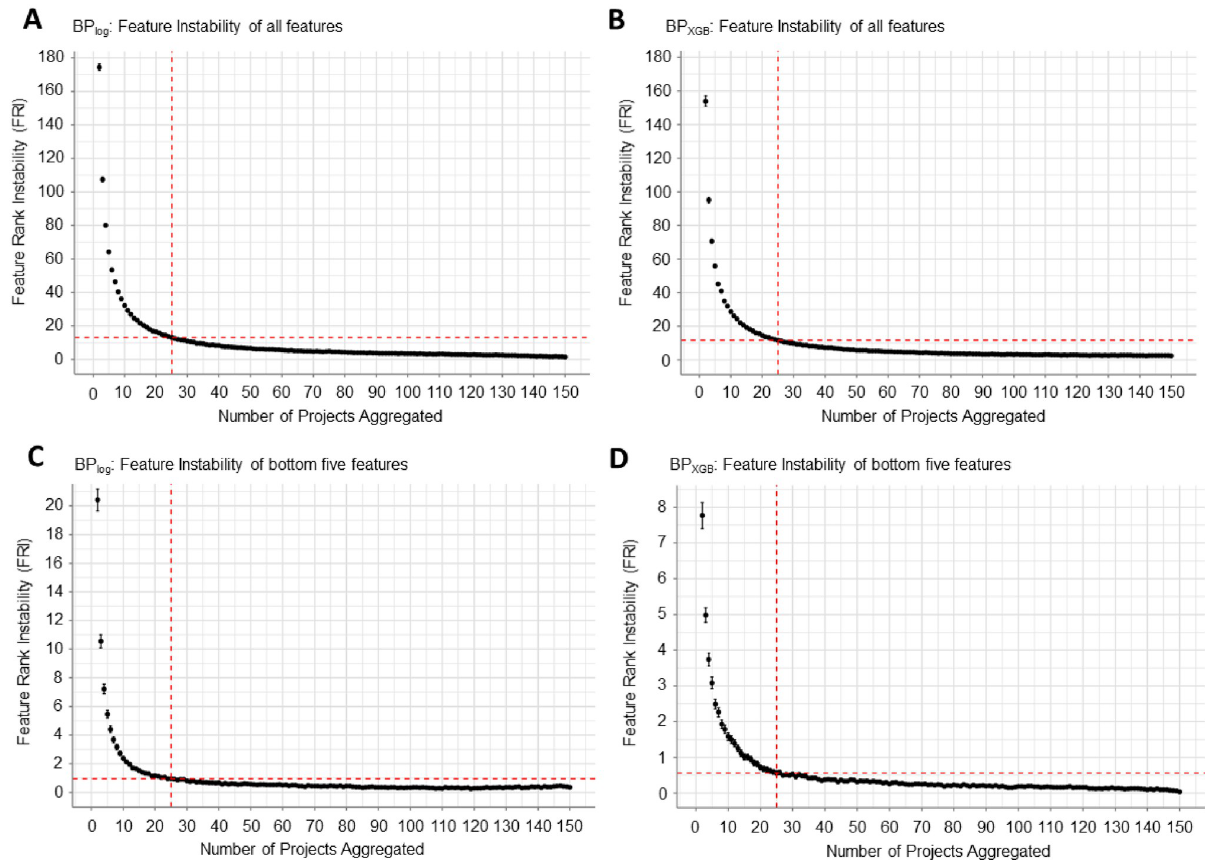
Fig 3. Feature rank instability (FRI) analysis as a function of number of projects aggregated. As the number of projects increased, FRI decreased (i.e. pFI ranking became more stable). (A, B) Expected FRI calculated for all 46 features. BP log had an average FRI of 174.40 ± 2.14 with 2-project aggregation and 13.03 ± 0.34 with 25-project aggregation (A). Similarly, BP XGB started with an average FRI of 153.83 ± 3.06 that decreased to 11.65 ± 0.33 at 25 projects (B). (C, D) Focusing only on the bottom five features by pFI to calculate FRI, BP log had an average FRI of 20.41 ± 0.75 with 2-project aggregation and decreased to 0.96 ± 0.08 with 25-project aggregation (C). Similarly, BP XGB started with an average FRI of 7.77 ± 0.37 and decreased to 0.56 ± 0.06 for the bottom five features with 25-project aggregation